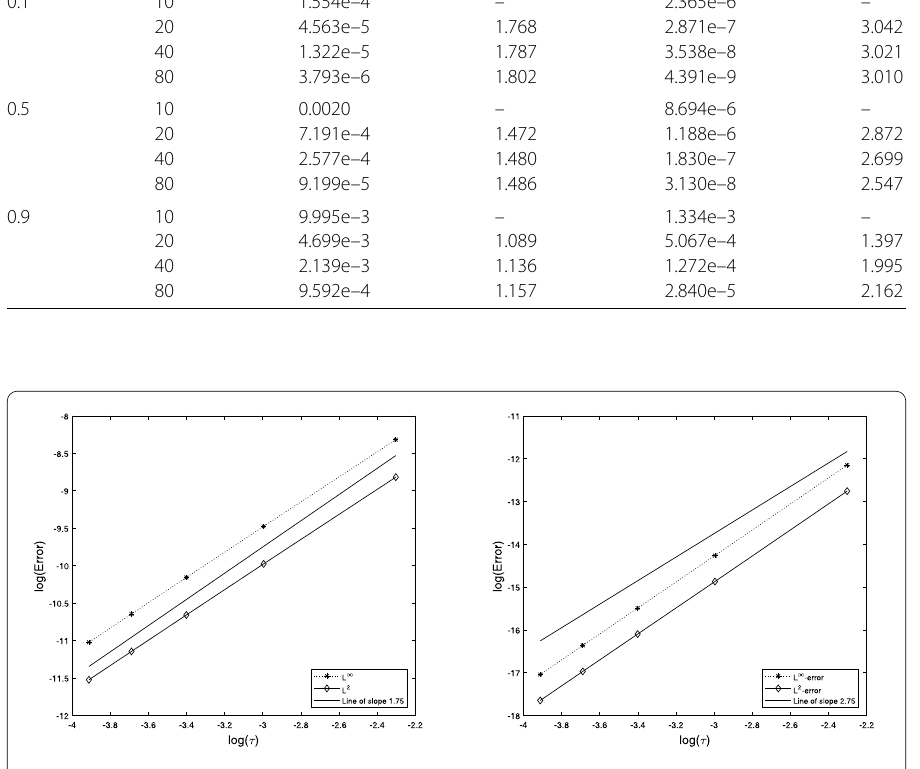
Figure 1 Time errors as a function of the time step sizes with α = 0.25 for Example 1. ( a ) Scheme CS1DI , ( b ) scheme